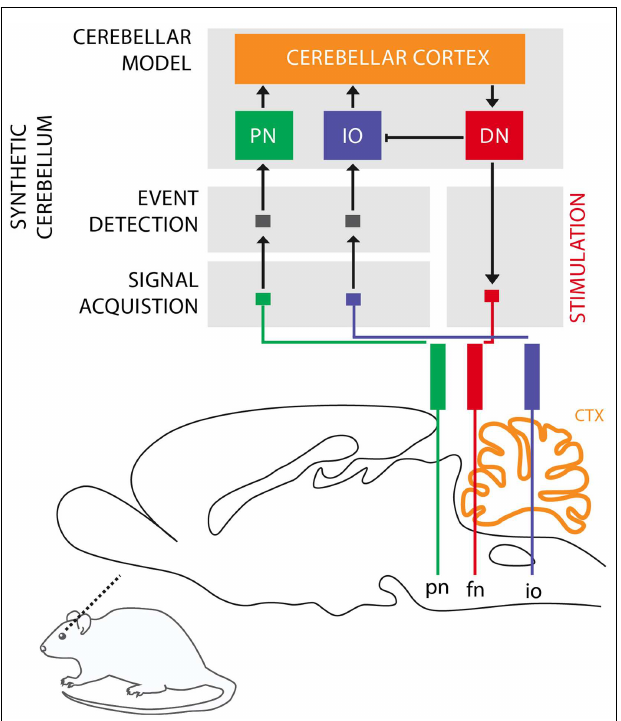
FIGURE 1 | Biological microcircuit and synthetic counterpart. Recording (PN and IO) and stimulation sites are shown. After amplification and filtering of the signals recorded in the afferent structures, discrete events retrieved from multi unit activity are isolated by the event detection stages of the system, such that they are fed to their counterparts in the synthetic cerebellum (PN and IO). In the intact circuit, the repeated coincidence of CS and US signals within the cerebellar cortex induces plasticity causing the cerebellum to respond to the CS with a CR. In our model, once such a CR is acquired, it is relayed via the synthetic DN to the facial nucleus (FN) of the rat as an electrical stimulation that causes the animal to trigger the behavioral CR, i.e., the eye-blink. In addition, within the model, the CR triggered by the DN inhibits the IO, preventing a US-derived signal from reaching the cerebellum once a protective action has already been issued. Since anesthesia prevents acquisition in the rodent’s cerebellum, behavioral CRs expressed in the set up studied here are controlled by the synthetic